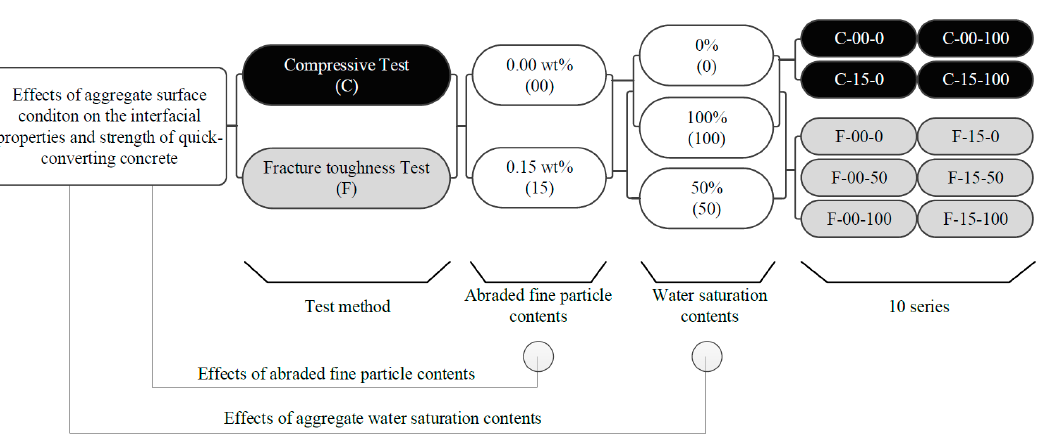
Figure 1. Details of the experimental program.